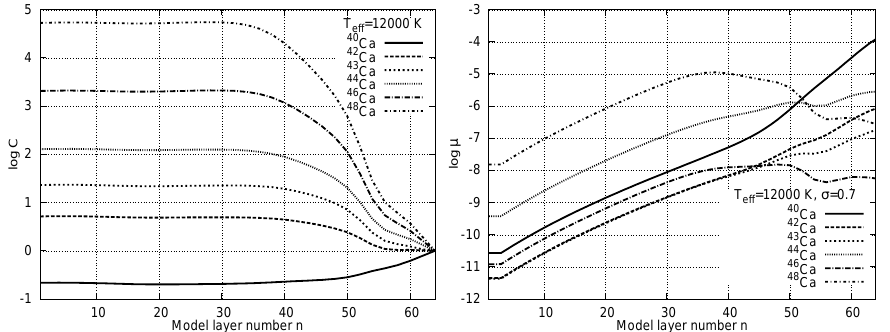
Fig. 1. The Ca isotope concentrations C relative to the solar values (left) and the corresponding isotope slab densities (cid:22) (right). The Ca isotope inner boundary con- centrations are assumed to be the solar ones. The model parameters are log g = 4 : 0, T eff = 12 000 K. The larger is the mass of the isotope, the higher is its concentration. The mean value of the impact cross section is (cid:27) = 0 : 7 (cid:1) 10 (cid:0) 16 cm 2 .